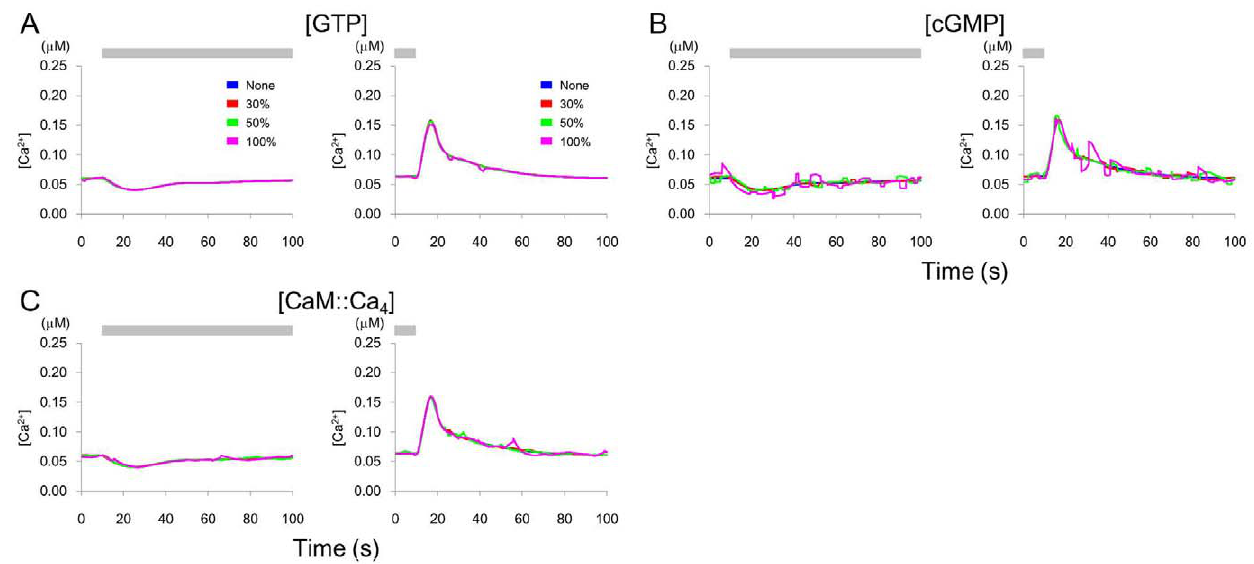
Figure 6. Changes in [Ca 2 + ] by fluctuation of the concentrations of substances. Change in [Ca 2 + ] when the concentrations of substances are determined using a random pulse train. Addition and removal of odor stimulus, and the colors of line are same as those in Fig. 5. The component is indicated in each panel. A. GTP, B. cGMP, C. CaM::Ca 4 where Ca 4 indicates four calcium ions.